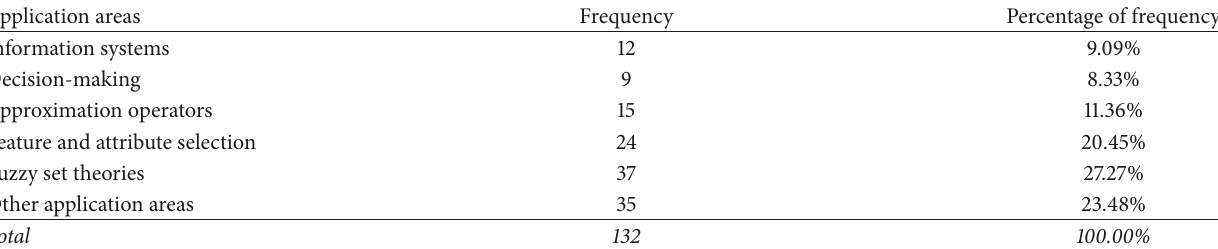
Table 1: Classification of papers based on application